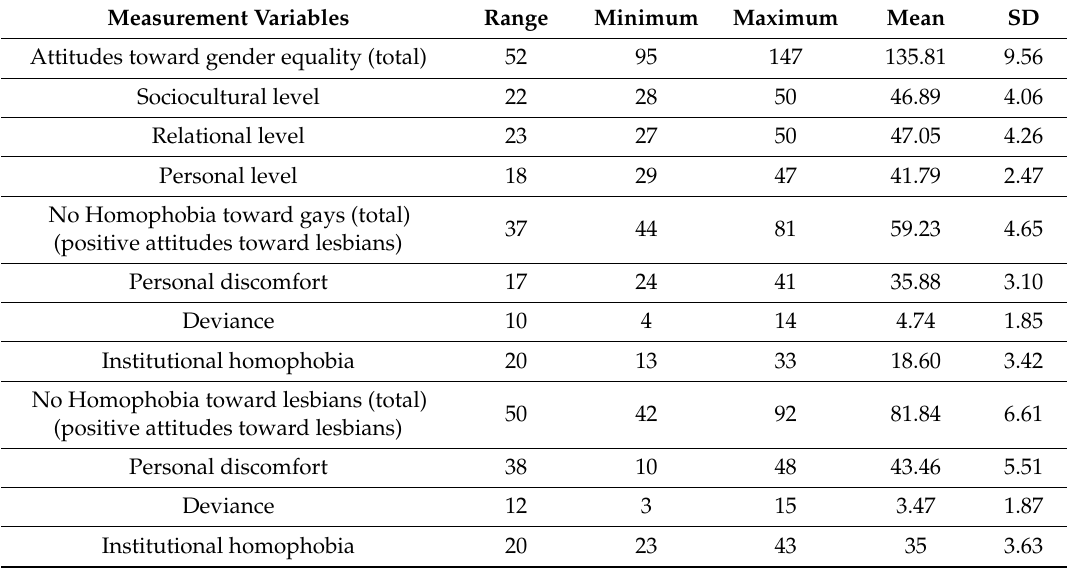
Table 1. Descriptive results (range, mean, and SD) of attitudes toward gender equality, homophobia toward gays, homophobia toward lesbians, resilience, self-esteem, emotional intelligence, empathy, and levels of everyday stress in university